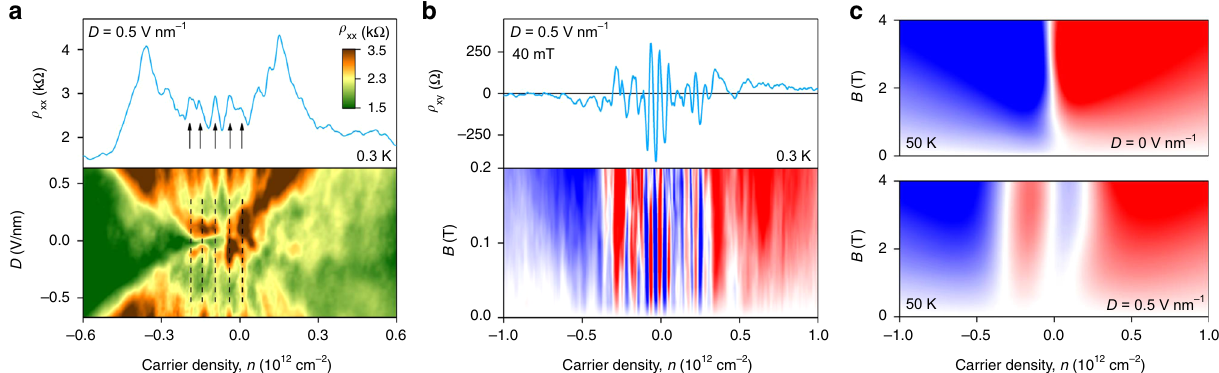
Fig. 3 Minibands in the gapped state of marginally twisted BLG. a Longitudinal resistivity as a function of n and D at 0.3 K. Upper panel: Crosscut of the map at D = + 0.5 V nm − 1 . b Same oscillatory behavior in Hall resistivity as a function of n and B for the given D . Color scale: ±250 Ohm. Upper panel: Crosscut at B = 40 mT. The arrows in a mark some of the maxima in ρ ρ xx which correspond to NPs (zero xy ) in b . c , Same as b but measured at 50 K. Upper and lower panels are for D = 0 and 0.5 V nm − 1 , respectively. Color scale: ±3